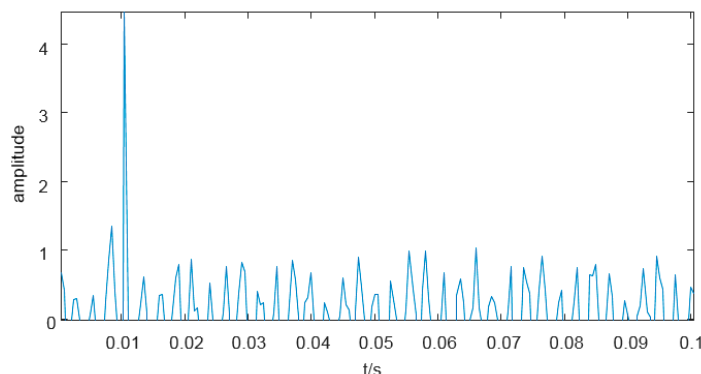
Figure 3. Time delay of arrival (TDOA) estimating based on the generalized cross-correlation (GCC)-phase transformation (PHAT) methods. The sound signal waveform reached the peak when t was 0.01 s.